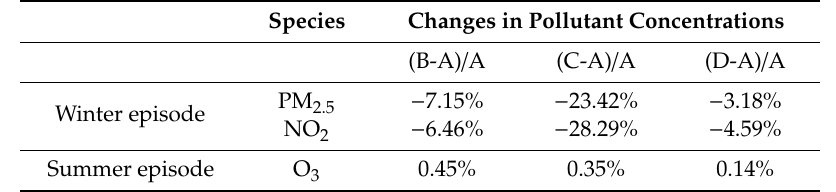
Table 3. Changes in pollutant concentrations in Haizhu district of scenarios (A, B, C, and D are scenarios